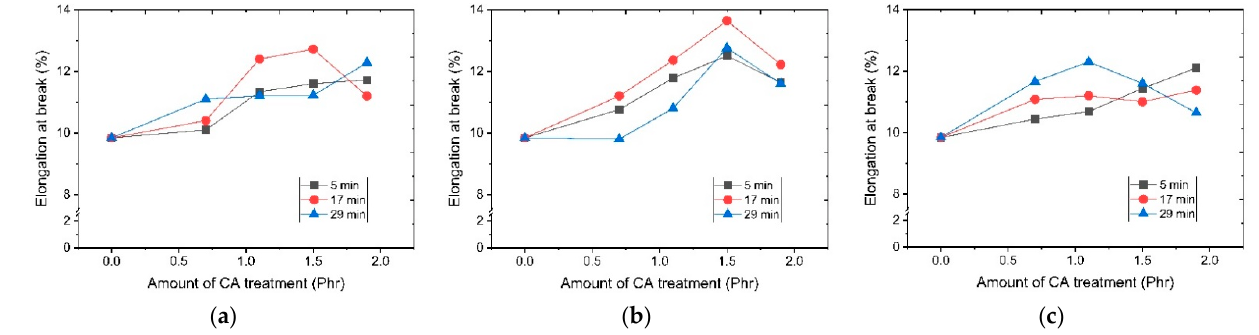
Figure 5. Strain rates depending on surface modification temperature and CA addition amount: ( a ) 130 °C; ( b ) 150 °C; ( c ) 170 °C.